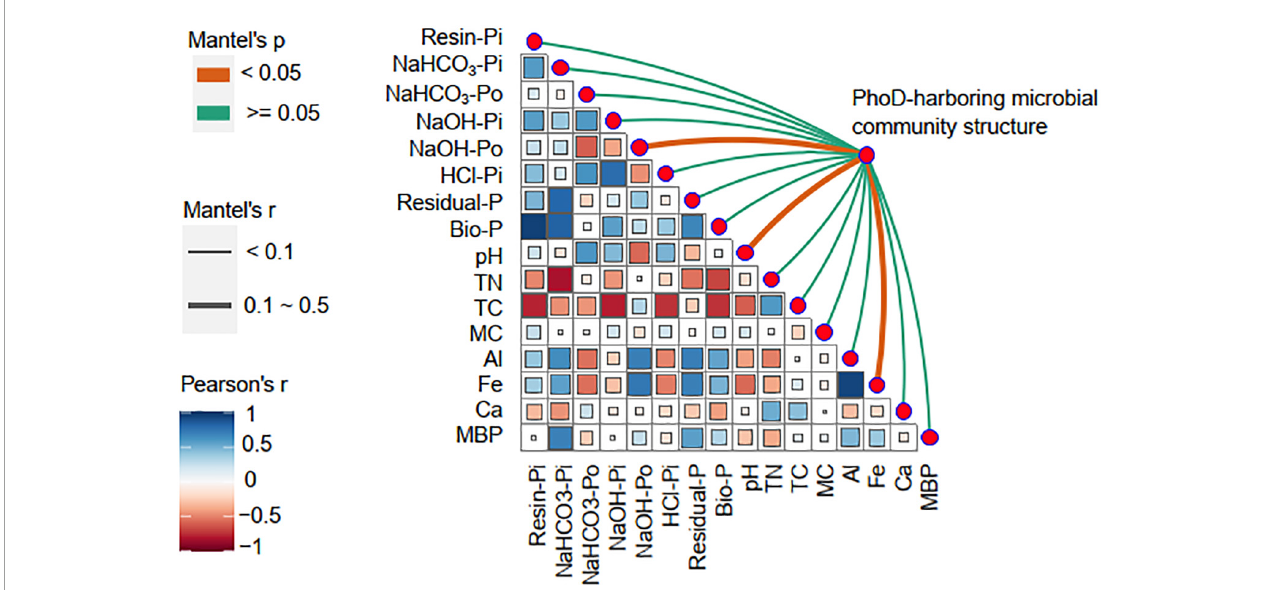
FIGURE6 Correlations of environmental factors with phoD-harboring microbial community structure. Pairwise comparisons of environmental factors are shown, with a color gradient denoting Pearson correlation coefficient. The diversity of phoD-harboring microbial community were related to each environmental factor by Mantel tests. Edge width corresponded to the Mantel’s r statistic for the corresponding distance correlations, and edge color denoted the statistical significance based on 999 permutations.